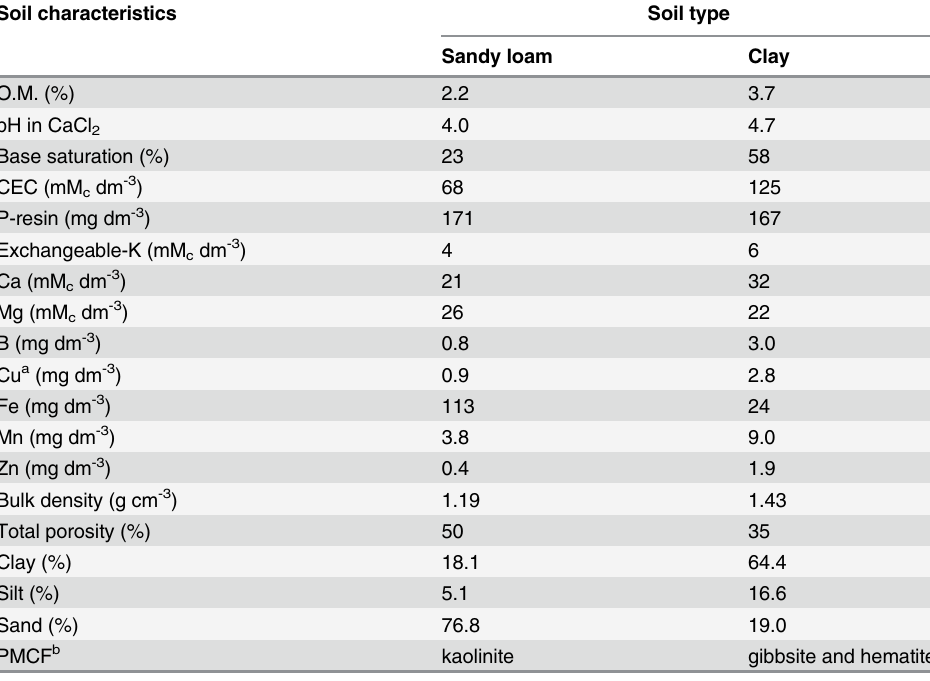
Table 1. Selected soil characteristics. Soil